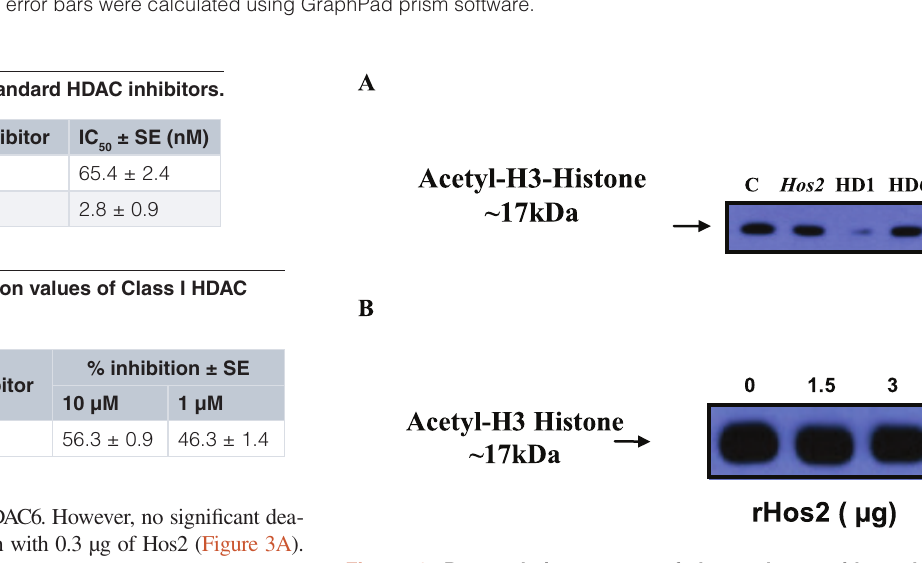
Figure 3. Deacetylation assays of deacetylases with nuclear histones. A . Histone H3 acetylation determined by Western blot of extracted acetylated histones (2 μg) Control (Lane 1), incubated with 300 ng of recombinant Hos2 protein (Lane 2), recombinant human HDAC1 (HD1 Lane 3) and recombinant human HDAC6 (HD6 Lane 4) for 1 hour at 37°C in HDAC assay buffer. B . Histone H3 acetylation determined by Western blot of extracted acetylated histones (2 μg) isolated from C. albicans , incubated with different concentrations of recombinant Hos2 protein for 1 hour at 37°C in HDAC assay buffer.